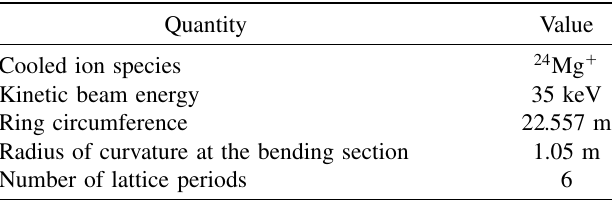
and k are selected 1 2 (cid:5) (cid:3) ; k 1 2 (cid:5) (cid:3) (cid:4) 2 : 072 ; 2 : 072 (cid:5) ; (cid:5) x y